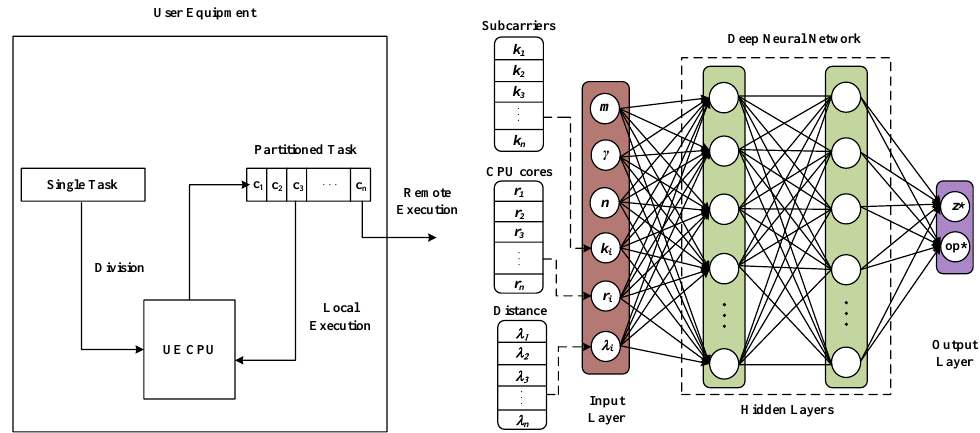
Figure 1. The proposed system model with the partitioning